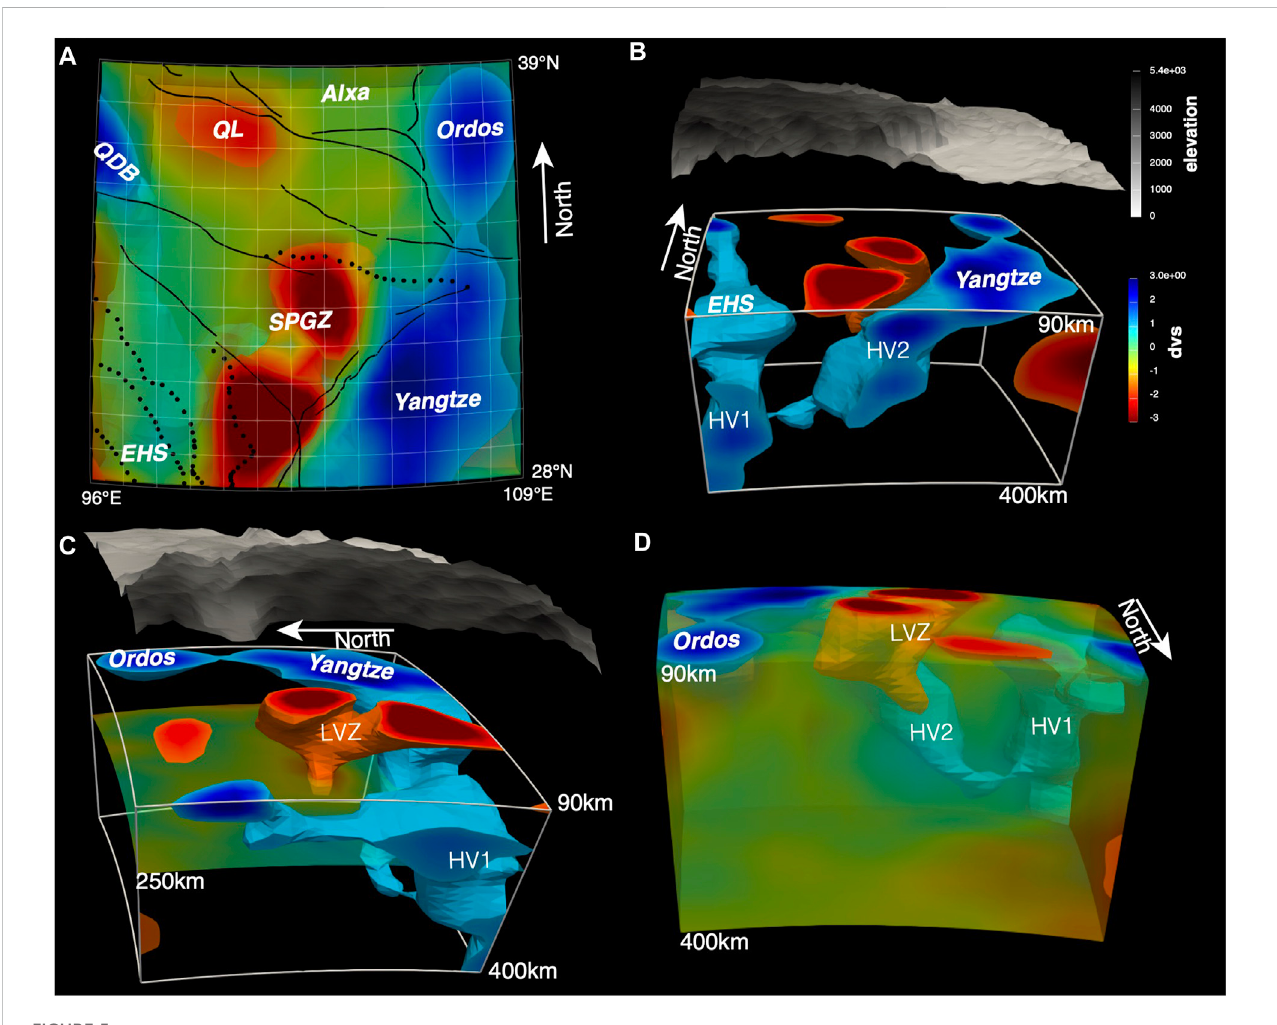
FIGURE 5 Mapview (A) and3-Dvisualizationofuppermantleshearvelocitystructuresfromsouth (B) ,east (C) andnorth (D) direction.HV1:subverticalhighvelocity